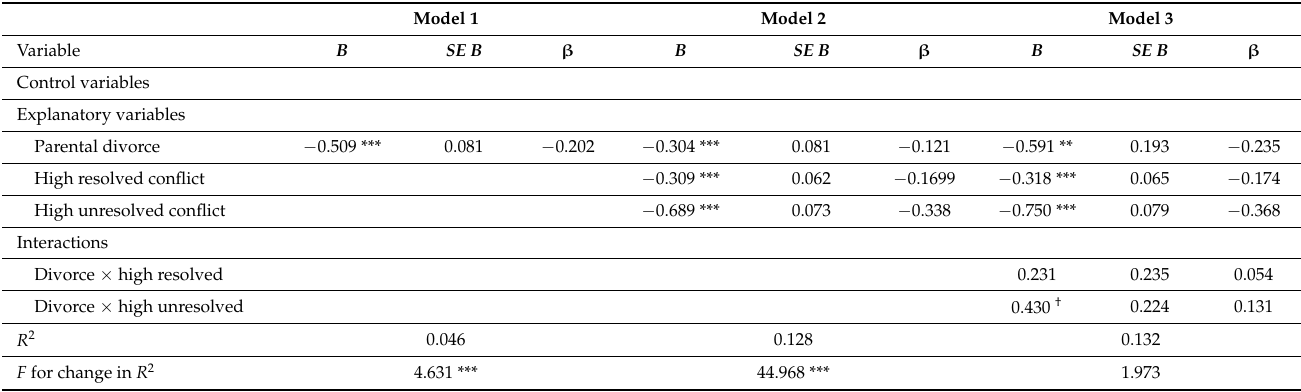
Table 7. Summary of the hierarchical multiple regressions for the variables predicting communication in father-child relationships.